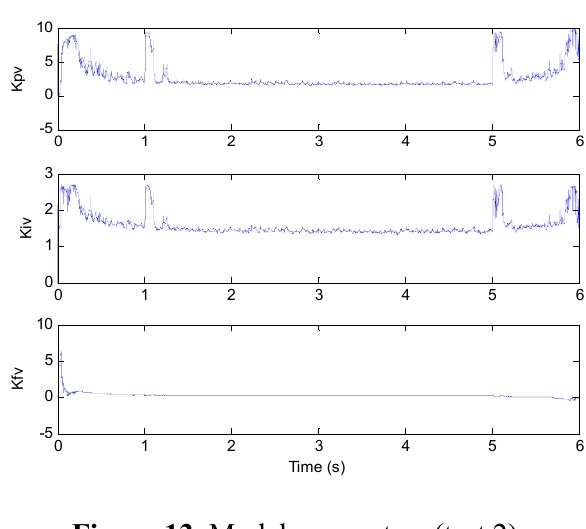
Figure 13. Model parameters (test